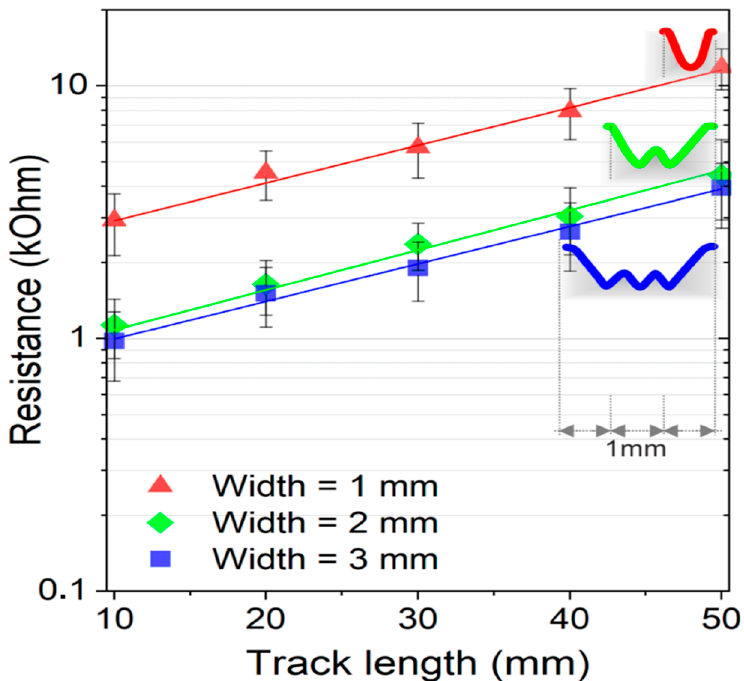
Figure 5. The electrical resistance of conductive tracks with different lateral sizes (1, 2 or 3 mm) and lengths (10, 20, 30, 40 and 50 mm) obtained on MWCNTs/PP polymer composite materials containing 1.5 wt.% of MWCNTs.